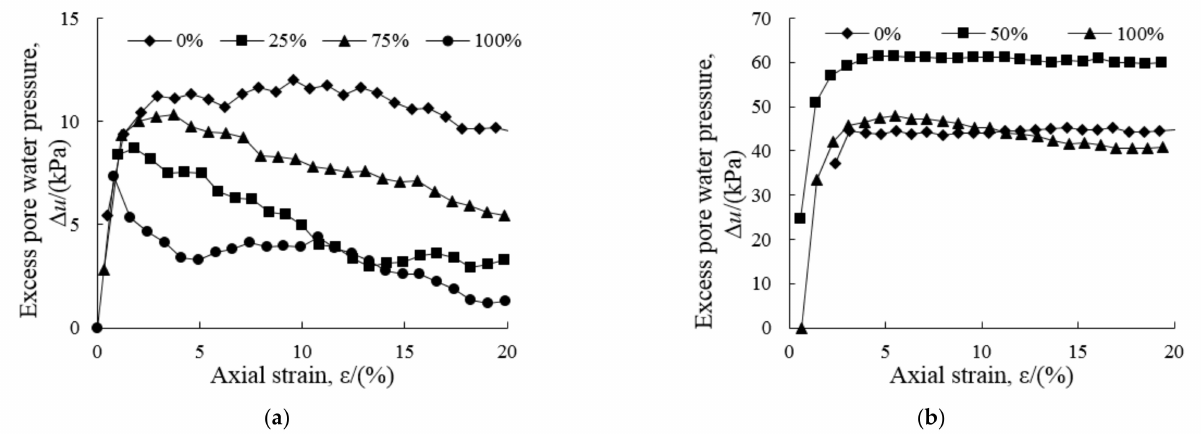
Figure 11. Variations of excess pore water pressure versus axial strain of the soft soil with different degrees of reconsolidation after cyclic loading ( n = 1000, CSR = 0.25): ( a ) p (cid:48) 0 = 20 kPa; ( b ) p (cid:48) 0 = 60